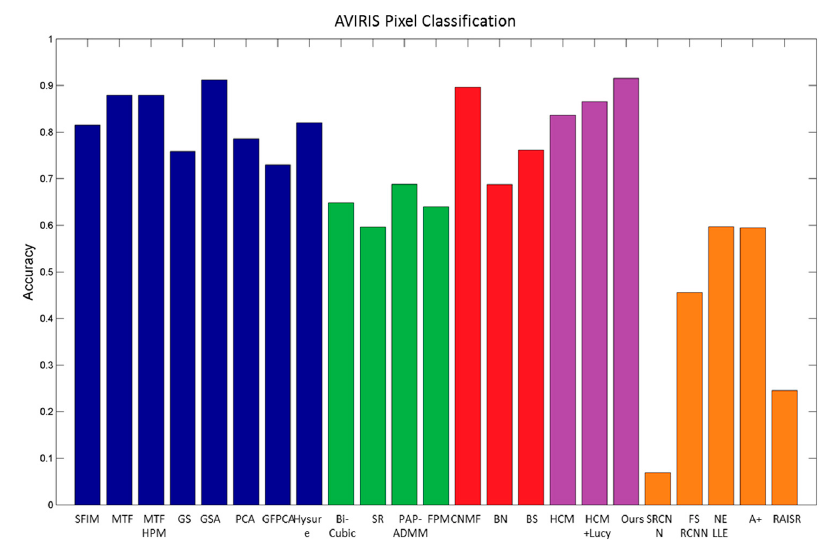
Figure 14. Clustering accuracy using different algorithms for the AVIRIS dataset. Red: Group 1 methods; Blue: Group 2 methods; Green: Group 3 methods; Purple: HCM methods; Orange: Group 4 methods.